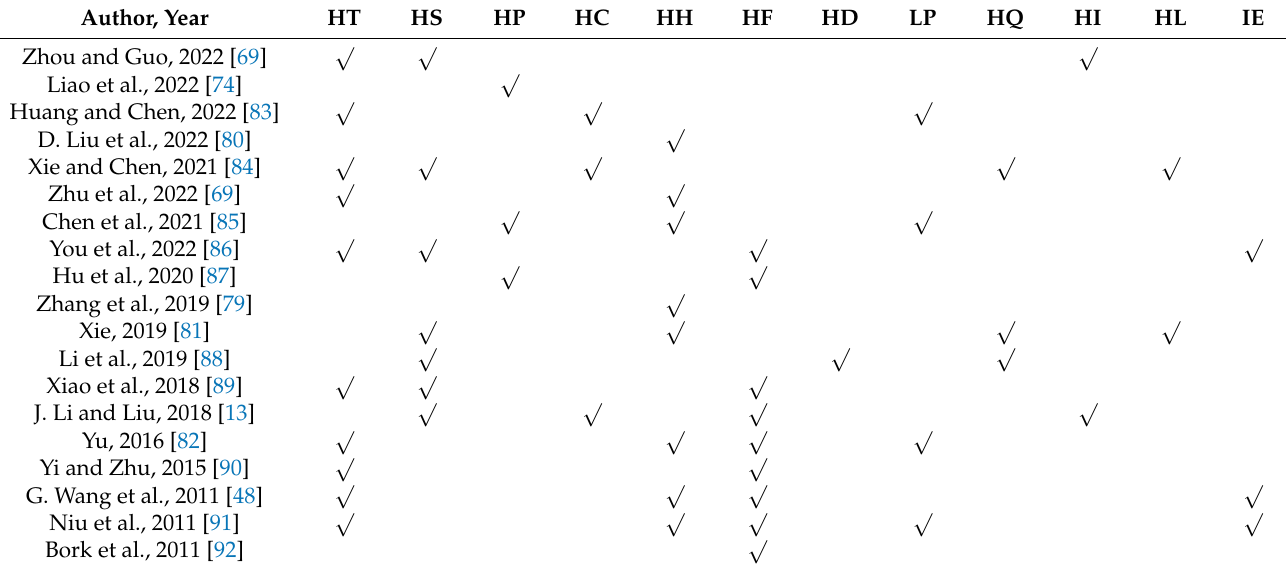
Table 4. Housing conditions, migrant’s health and well-being included in the